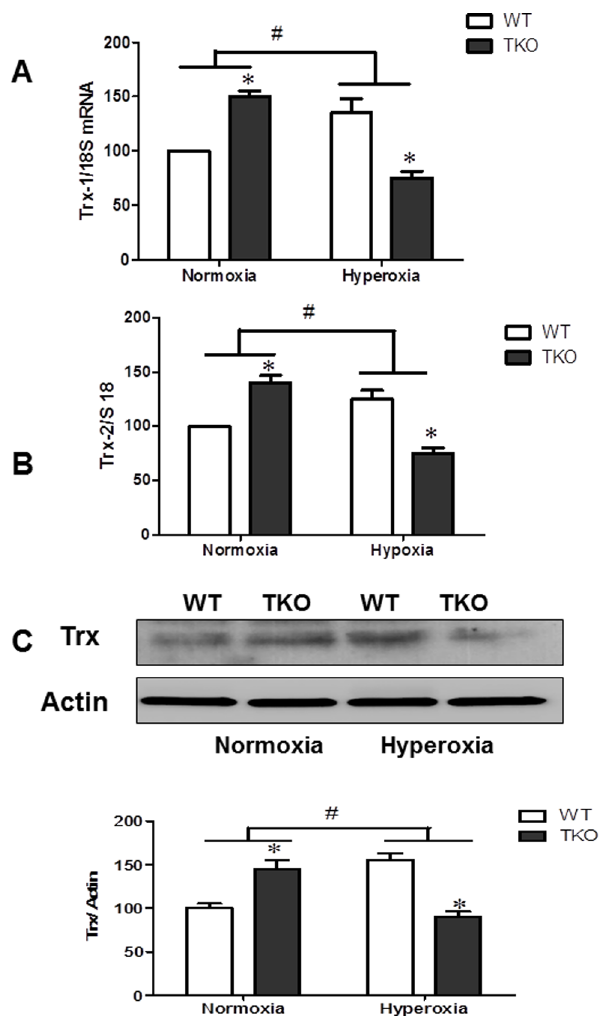
Figure 6. Deletion of TXNIP decreases thioredoxin levels under hyperoxic conditions. WT and TKO mice were subjected to 5 days hyperoxia (p7–12). Retinas were collected for protein and mRNA levels of thioredoxin (cytoplasmic Trx-1) ( A ) as well as mitochondrial Trx-2 ( B ) and total thioredoxin protein ( C ). A 2 6 2 analysis showed a significant interaction between gene (TKO) and oxygen levels (Hyperoxia) in both Trx-1 and Trx-2 as well as Trx total expression. Exposure of TKO pups to hyperoxia significantly decreased the anti-apoptotic thioredoxin on both mRNA as well as protein level compared to WT. ( # P , 0.05 Hyperoxia vs Normoxia, *P , 0.05, TKO vs WT, n=4–6).